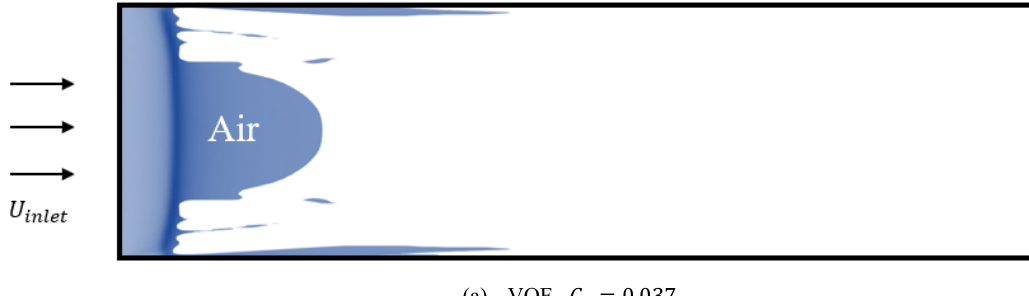
Figure 14. Total drag reduction at various injected air flow rates.